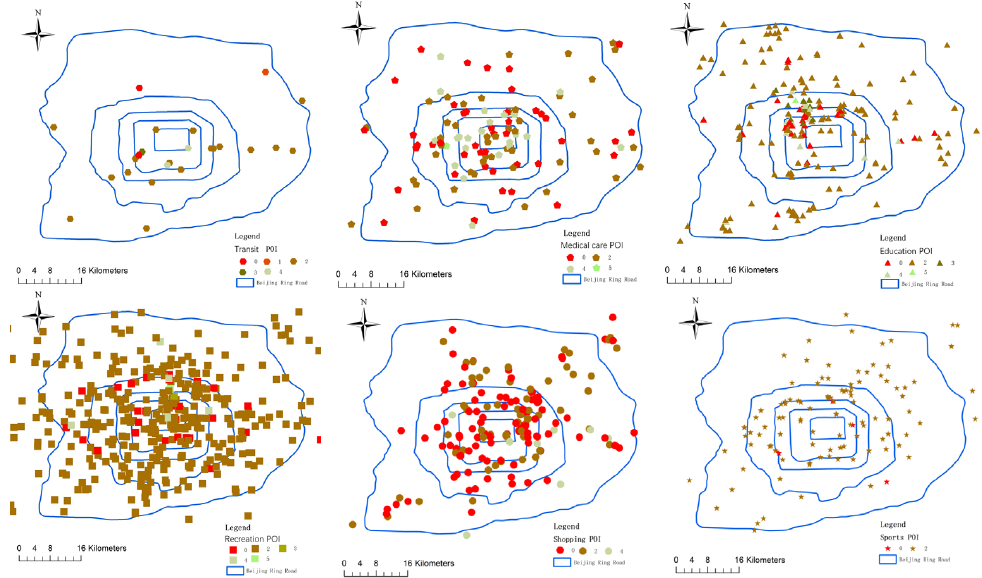
Figure 13. Patterns of changes in pedestrian flow at different hotspot locations in Beijing during the preliminary resumption of work.